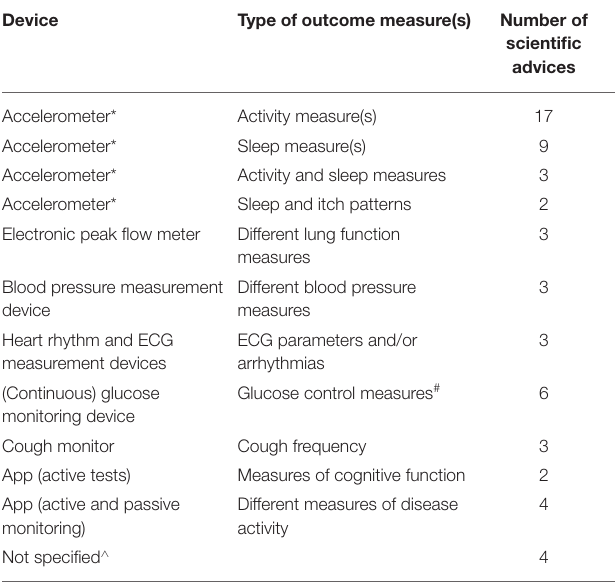
TABLE 1 | Overview of remote monitoring devices and outcome measures of the scientific advices.